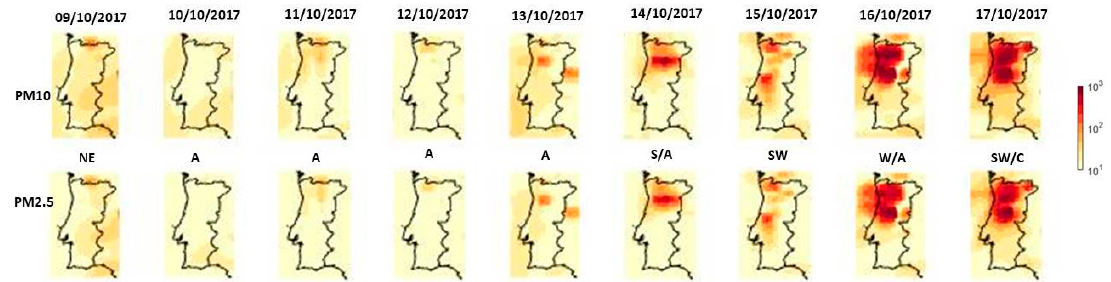
Figure 7. PM10 (upper panel) and PM2.5 (lower panel) maximum concentrations extracted through the near-real time data from Copernicus Atmosphere Monitoring Service (CAMS-NRT) and CWT observed over the period 9th–17th October 2017.